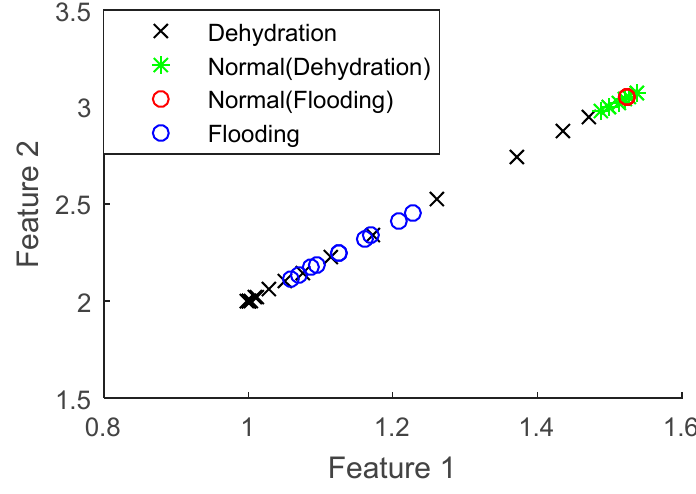
Figure 3. Fault diagnosis performance using voltage only.